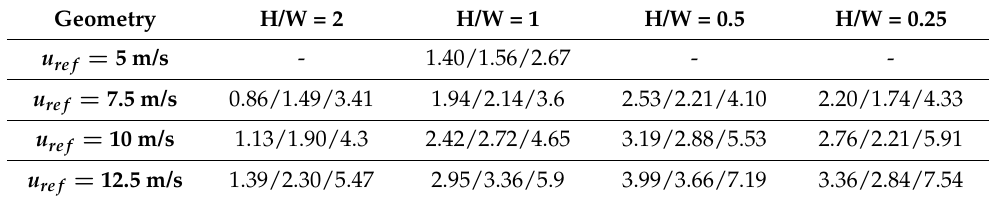
Table 1. Mean values for y+ for the bottom, the side walls, and the roof surfaces in the street canyons. Note that the y+ value was evaluated for the fourth and the following street canyons because the influence of the upstream building in the first three canyons was evident, and they are not subjected to the